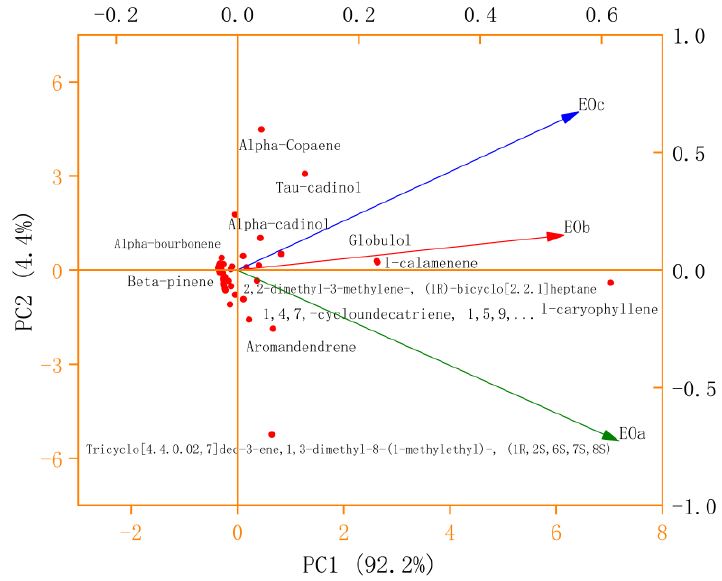
Figure 8. PCA analysis of EO compounds obtained by different extraction methods. Table 3. GC-MS detection of essential oil composition